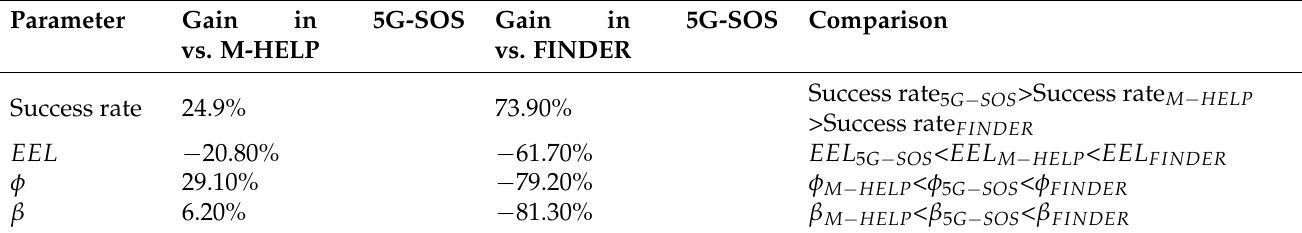
Table 6. Summary of performance